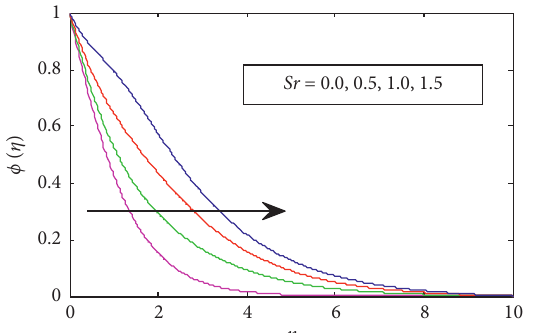
Figure 10: Angular velocity distribution for different values of material